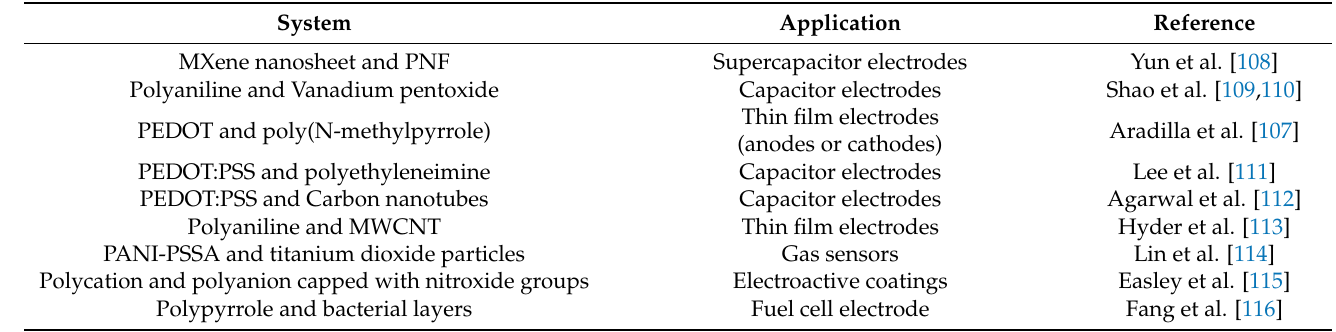
Table 1. Examples of LbL structures containing conductive polymers and their potential